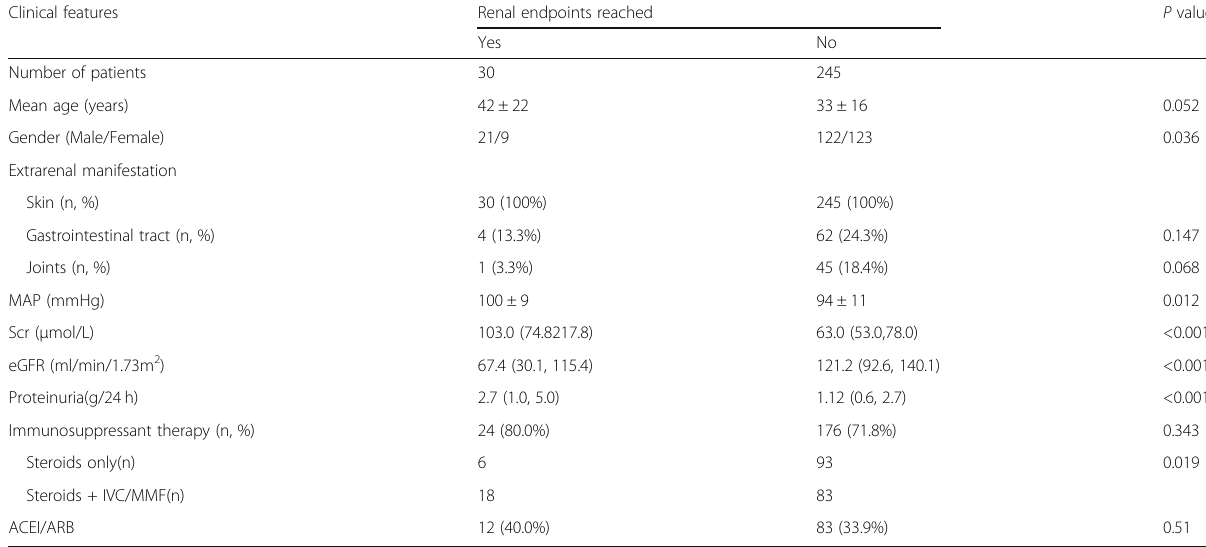
Table 1 Clinical features for patients with or without renal endpoints Clinical